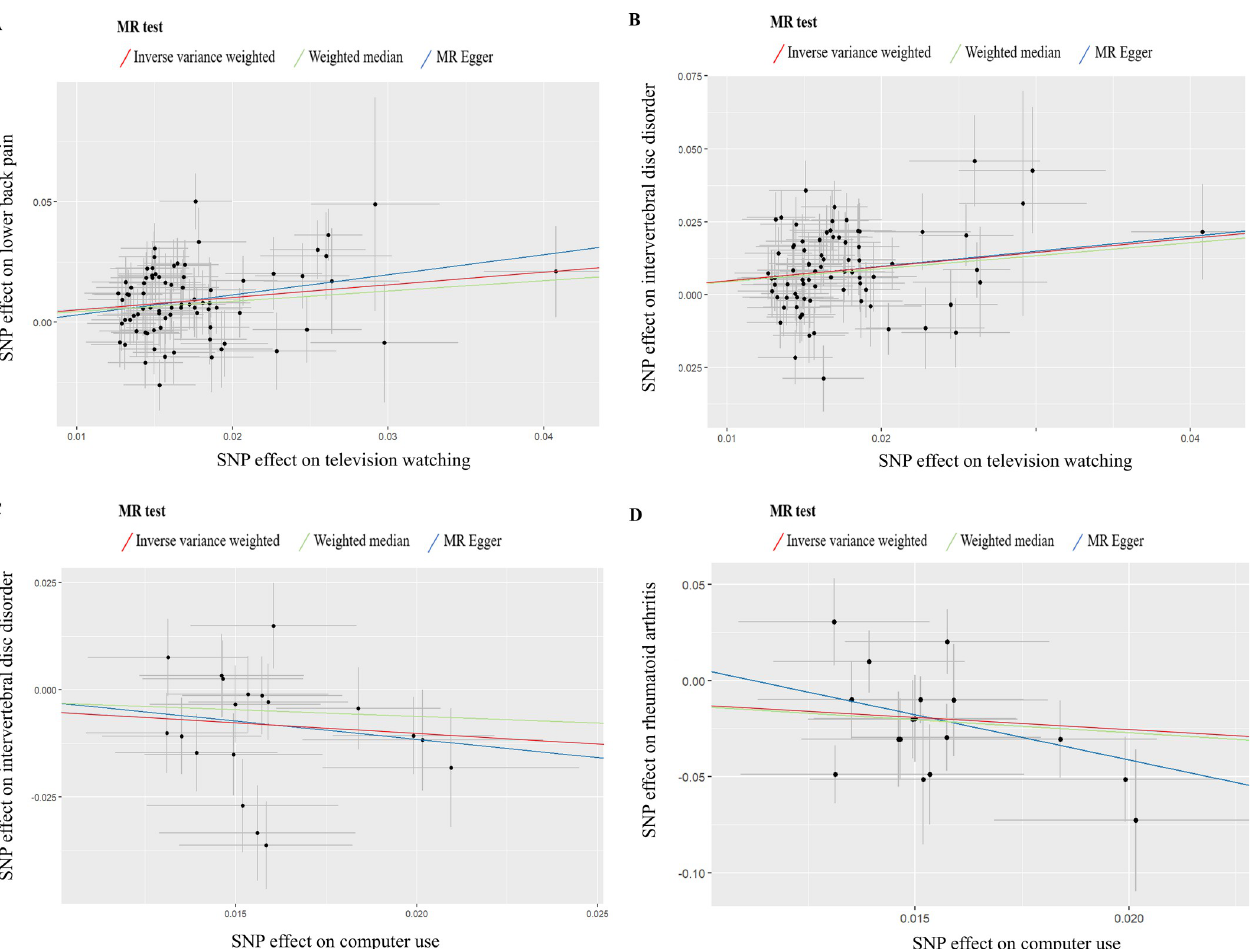
Fig 3. Scatter plots from genetically predicted television watching on lower back pain (A), television watching on intervertebral disc disorder (B), computer use on intervertebral disc disorder (C) and computer use on rheumatoid arthritis (D).